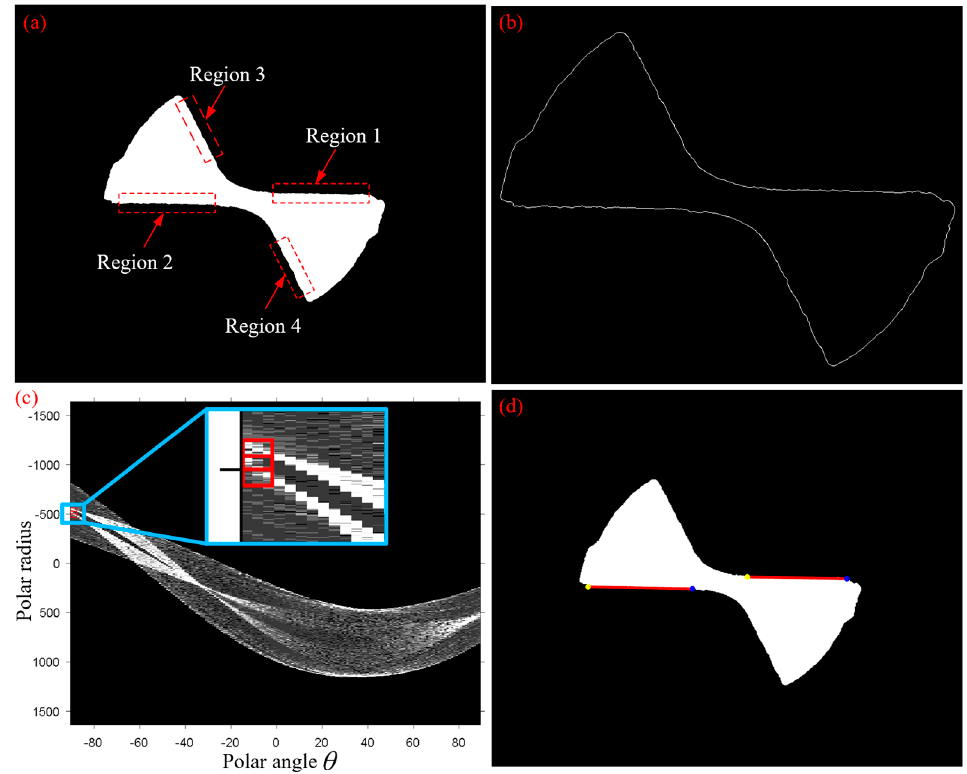
Figure 13. Hough transform of tool wear image: ( a ) segmented image; ( b ) boundary obtained by Sobel edge detector; ( c ) Hough transform of ( b ); ( d ) two longest straight lines in the original image.